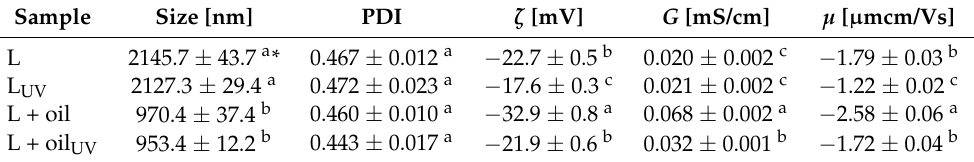
Table 1. Particle size, polydispersity index (PDI), zeta potential ( ζ ), conductivity ( G ), and mobility ( µ ) of the empty and Rosa canina seed oil-loaded liposomes measured immediately after the preparation and after the UV